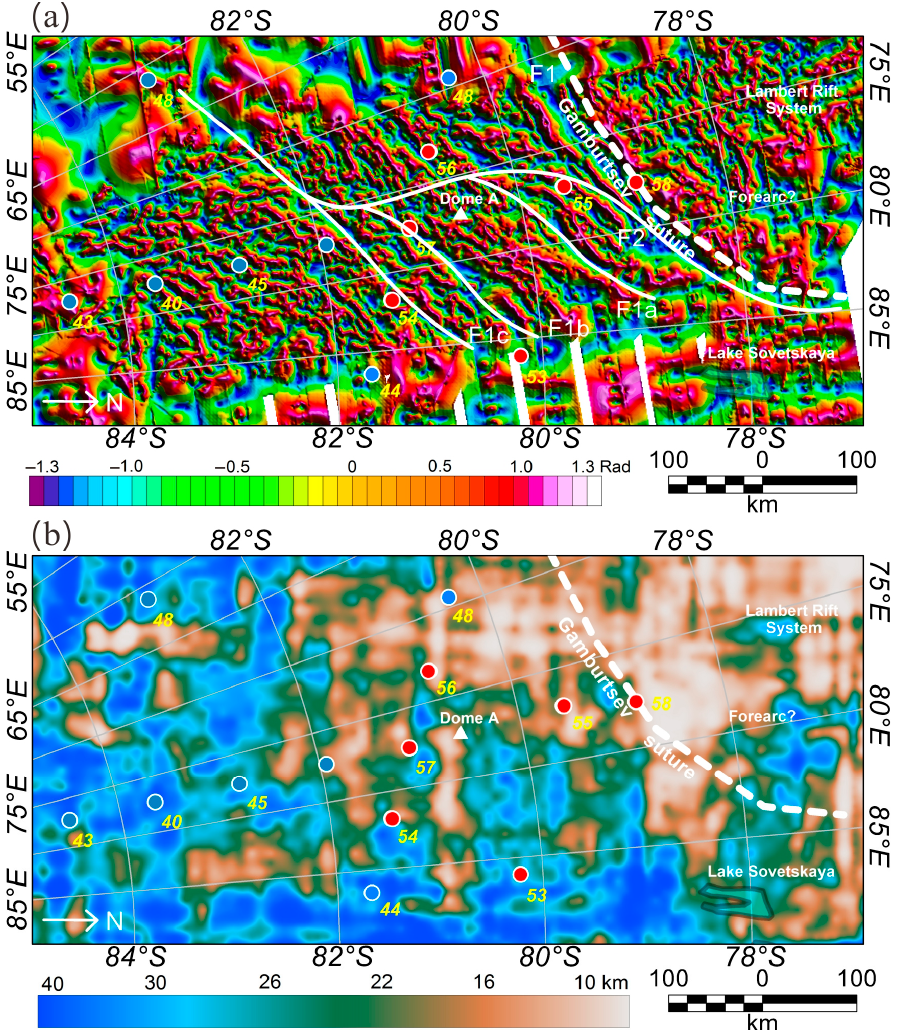
Figure 4. Aeromagnetic data processing and interpretation of the GSMs. ( a ) Magnetic tilt derivative map of the GSMs. ( b ) Curie depth map of the GSMs inversed from aeromagnetic data. Red and blue dots show the thick crust beneath the Northern and Central GSMs and thin crust beneath the southern GSMs from passive seismic data [8,14,15,39]. The number near these dots represent the crustal thickness.